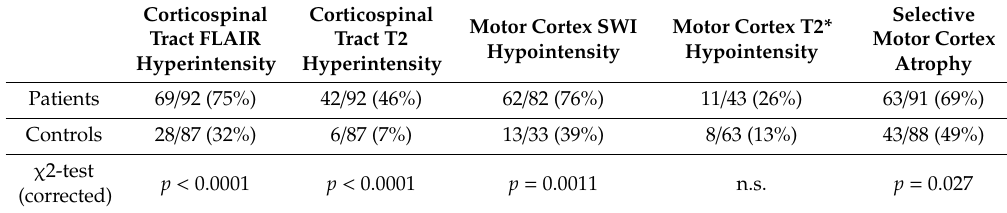
Table 2. Comparison of the prevalence of MRI features between ALS patients and controls.